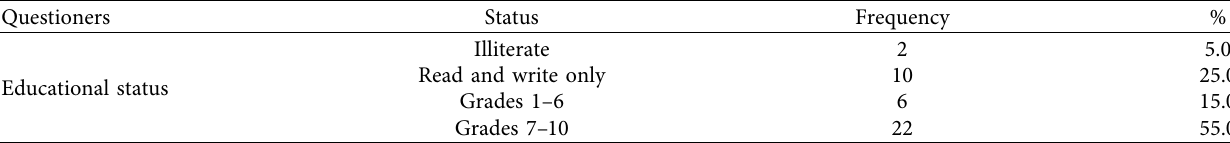
Table 1: Sociodemographic characteristics.